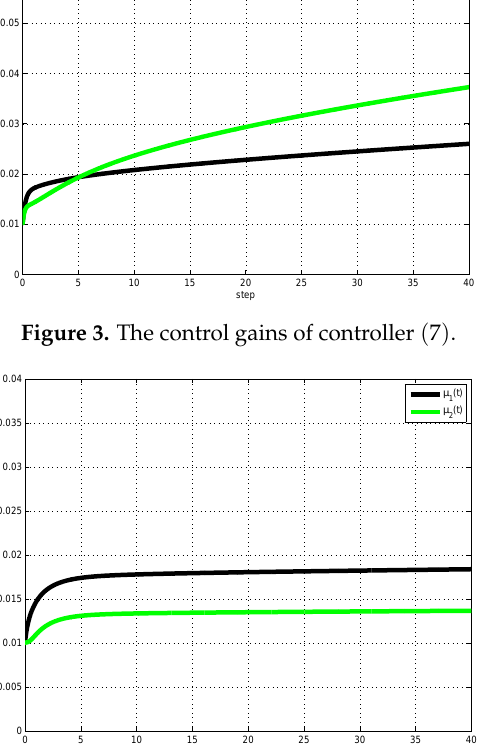
Figure 4. The control gains of controller ( 7 )